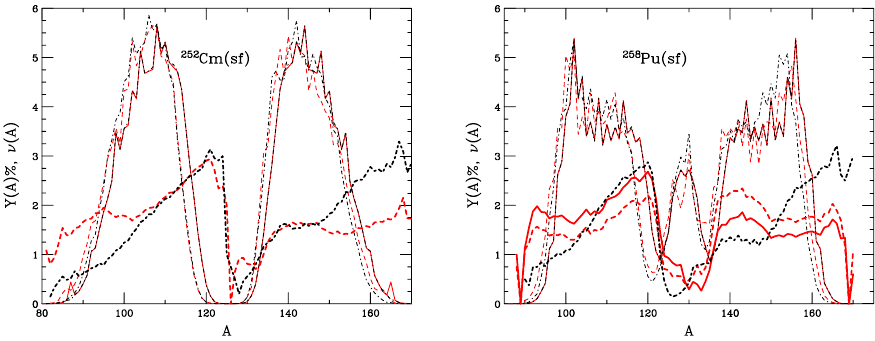
Figure 1. The fission fragment and fission product mass yields as well as the mean neutron multiplicity as functions of fission fragment mass number A for 252 Cm(sf) (left) and 258 Pu(sf) (right). The thin solid red curves are the fission fragment yields from FREYA based on the GEF yields, underneath the red curves, in black. The thin dashed red curves are the FREYA fission product yields, after prompt neutron emission, while the thin black dot-dashed curve is the GEF result. The Y ( A ) results are given in percent and are normalized to two fragments per fission, or 200 %. The thick curves show the mean neutron multiplicity as a function of the primary fission fragment mass. The red curves show the FREYA results for ¯ ν ( A ), while the black curve shows the GEF results. Note that the calculations for 258 Pu(sf) (right-hand panel) show two results for FREYA . The dashed curve uses a default value for the excitation energy sharing parameter x , x = 1 . 15, also used for the Cm calculation on the left, while the solid curve uses x = 1 . 4, fixed to match the GEF value of the average neutron multiplicity from GEF . Note that the FREYA Y ( A ) for fission product yields is obtained using x = 1 .